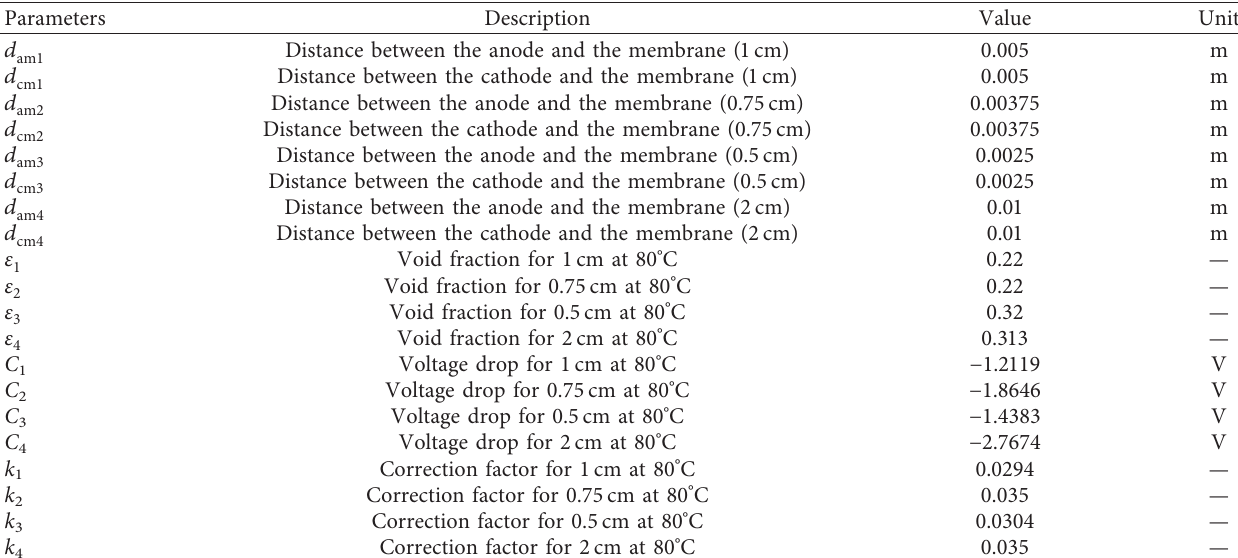
Table 6: Parameters specific to the experiment on interelectrode